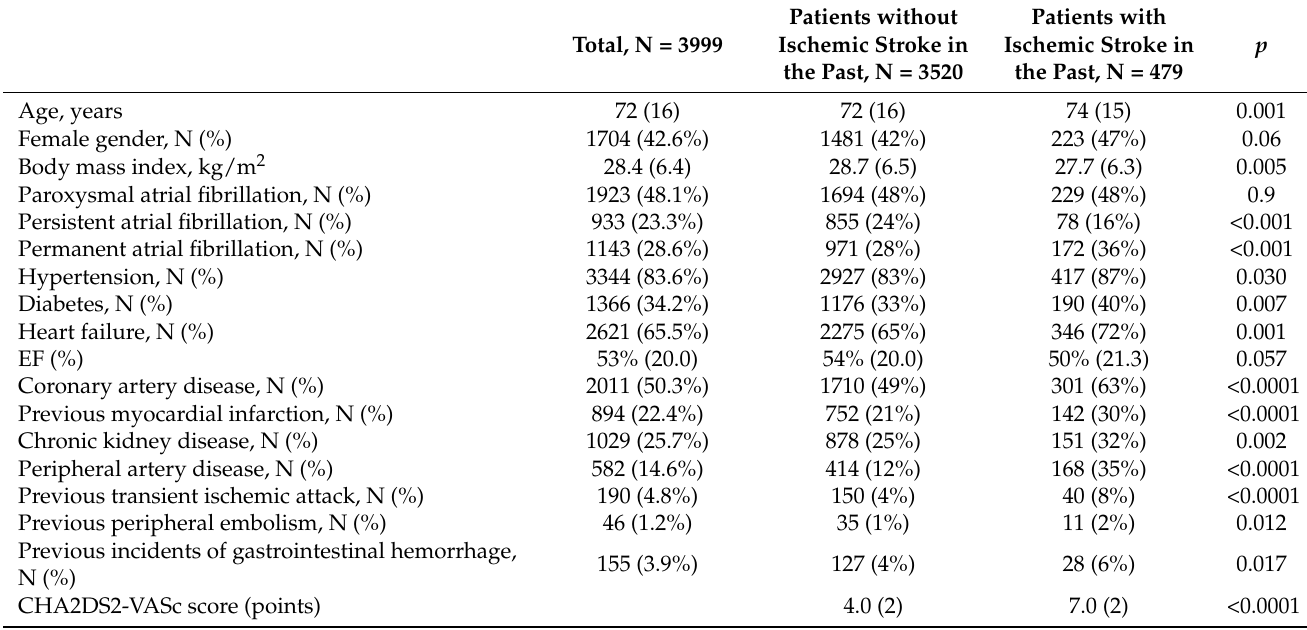
Table 2. Detailed characteristics of the study group.